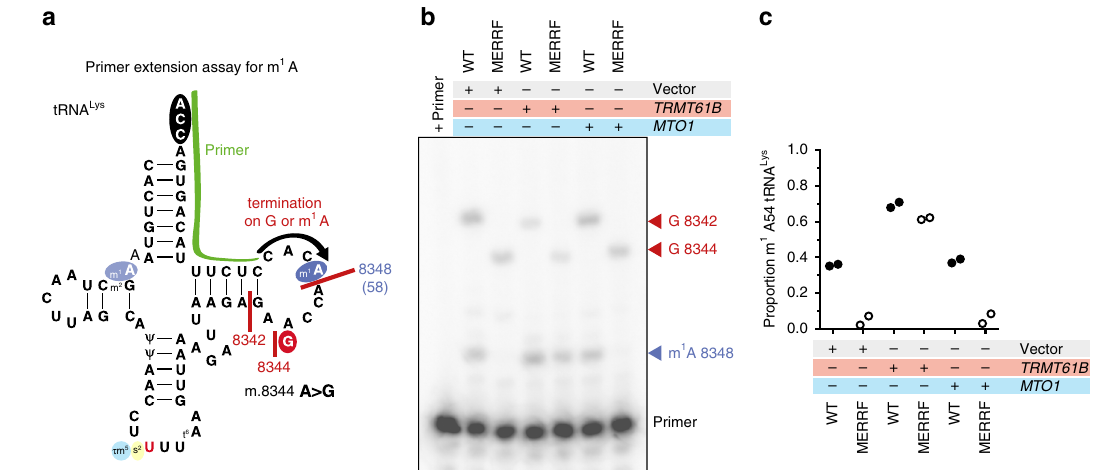
Fig. 4 Restoration of the m 1 A58 modi fi cation in tRNA Lys . a Schematic of the primer extension assay for genotyping m 1 A58 in tRNA Lys . b A representative primer extension analysis on total RNA from human myoblasts stably transduced by retrovirus with the indicated cDNAs. c Quanti fi cation of primer extension analysis from two independent experiments. Proportion of m 1 A58 was calculated as follows (m 1 A 8348 / (m 1 A 8348 + G 8342)) or (m 1 A 8348 / (m 1 A 8348 + G